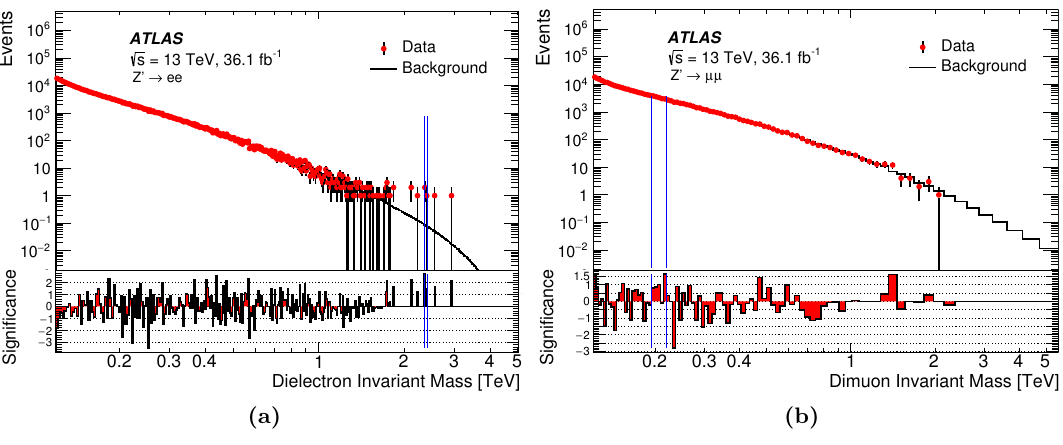
Figure 3 . Dilepton mass distribution in the (a) dielectron and (b) dimuon channel, showing the observed data together with their statistical uncertainty, combined background prediction, and corresponding bin-by-bin signi(cid:12)cance. The most signi(cid:12)cant interval is indicated by the vertical blue lines. Exact bin edges and contents are provided in table 10 and table 11 in the